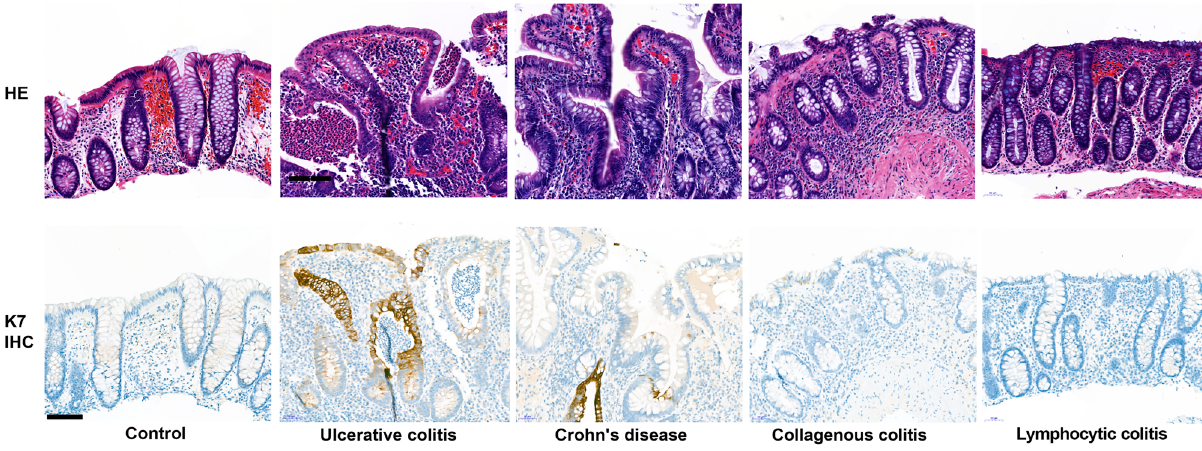
Figure 2. Typical K7 expression patterns in IBD and microscopic colitis. Images show for controls and the disease (ulcerative colitis, Crohn’s disease, collagenous colitis, lymphocytic colitis) representative K7 epithelial expressions (K7 IHC DAB brown color) and H&E staining from the same areas.